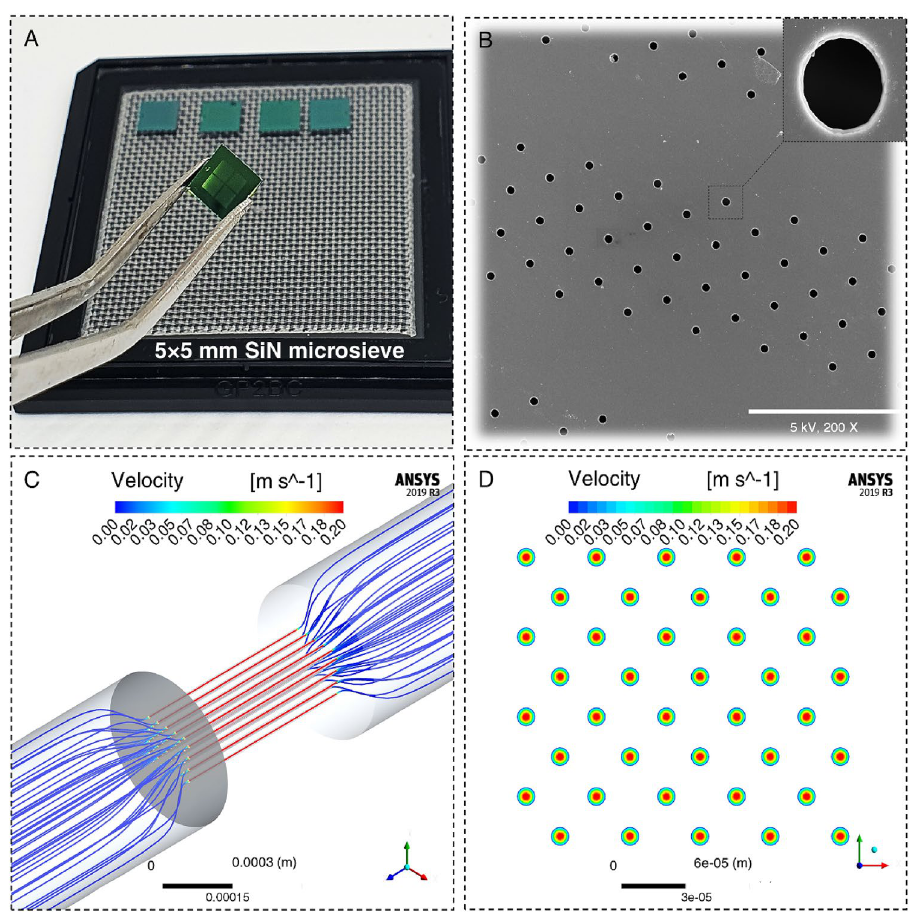
Figure 2. MFP microsieves and numercial analysis. ( A ) Unmounted SiN microsieves. ( B ) Each microsieve membrane is 5 × 5 mm containing 14 fields with 37% porosity increasing the throughput of the MFP approach (10 7 cell min -1 ). Scale bar indicates 100 µm. ( C , D ) These plans show the 3D illustration of streamlines passing through the microsieves with the inlet velocity of 0.24 m s −1 and the velocity contour of the cross-sectional area for 40 micropores, respectively. Figure ( C , D ) were generated using ANSYS 2019R3 (https:// www. ansys. com/ acade mic/ stude nts/ ansys- stude